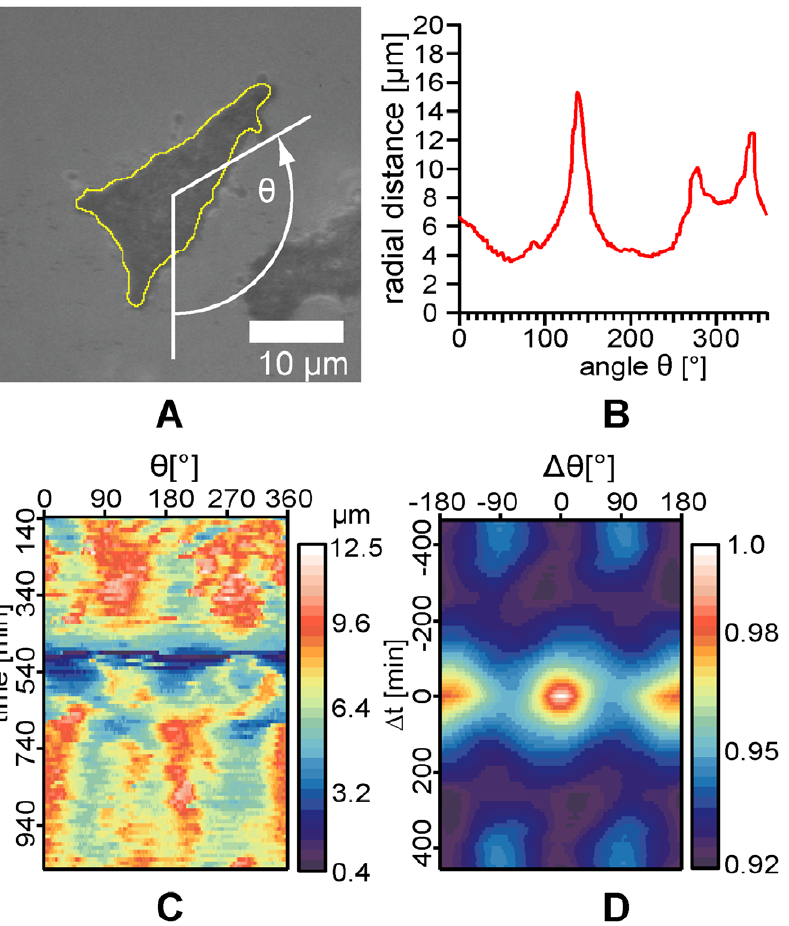
Figure 4. Time evolution of cell morphology. (A) A snap shot of an ASpSV14 cell on an oligo-HA-functionalized membrane ( , d . , 5.5 nm, t = 9 h) captured by RICM. The peripheral edge of the cell was determined by the contrast in pixel intensity. (B) The amplitude of the fluctuation amplitude R ( h , t ) ~ r ( h , t ) { S r ( h , t ) T h plotted as a function of h . S r ( h , t ) T h is the mean radial distance over h = 0–360 u . (C) The amplitude map as a function of angle h over time ( t = 140–1000 min). (D) The autocorrelation corresponding to the amplitude map in panel